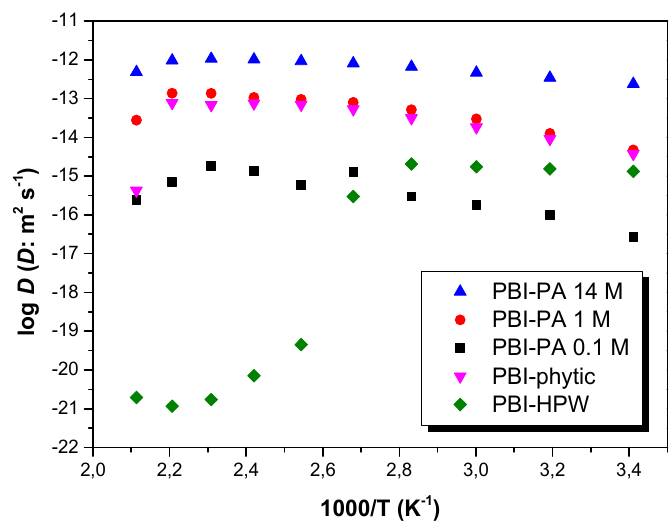
Figure 9. Temperature dependence of the di ff usion coe ffi cient ( D ) for PBI–PA 0.1 M ( (cid:4) ), PBI–PA 1 M ( • ), PBI–PA 14 M ( (cid:78) ), PBI–phytic acid (0.075 M) ( (cid:72) ), and PBI–HPW (0.1 M) ( (cid:7) ) membranes.